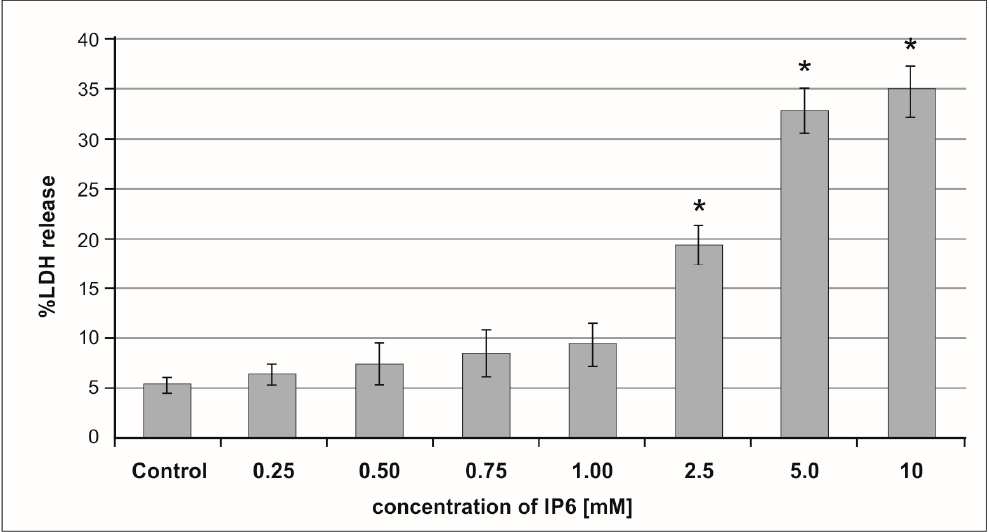
Figure 1. The effect of inositol hexaphosphate (IP6) on lactate dehydrogenase (LDH) release from Caco-2 cells after 48 h of incubation. The results are presented as mean ± standard deviation (SD) of six separate experiments, * p < 0.05 compared with untreated controls.